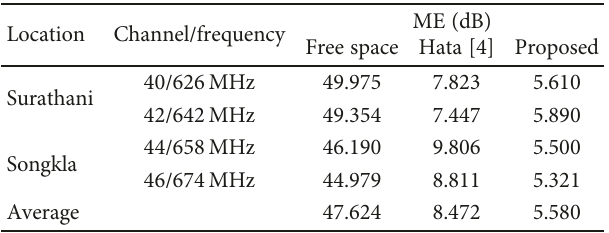
Table 2: LS calculative values. Table 3: ME calculative values.